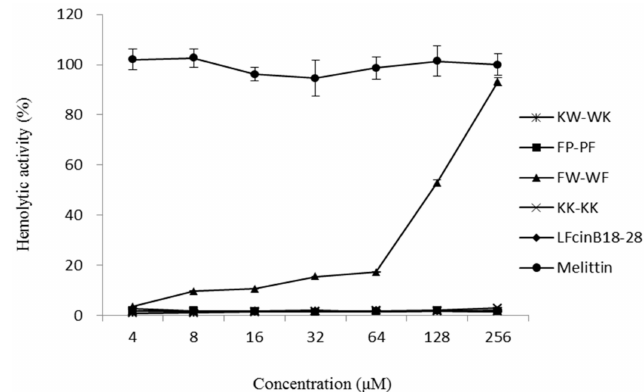
Figure 3. Hemolytic activity curves of each peptide against human red blood cells.